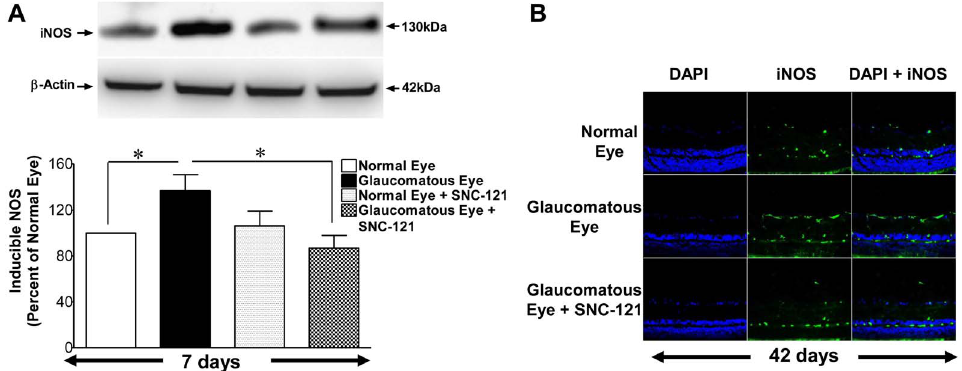
Figure 9. Changes in iNOS expression in glaucomatous retina at 7 and 42 days, post injury. (A) Brown Norway rats were treated with SNC-121 (1 mg/kg, i.p.) 30 minutes after glaucomatous injury and continued for 7 days, once daily. Retina extracts were collected at the 7 th day, post injury, and analyzed using anti-iNOS antibodies and appropriate secondary antibodies (HRP-conjugated; dilution 1:3000). The signal was captured using enhanced chemiluminescent reagent and the Biorad Versadoc imaging system. Data are expressed as mean 6 SEM. * P , 0.05; n=4. (B) The eyes of Brown Norway rats were removed 42-days post glaucomatous injury. Cryosections of retina were immunostained by anti-iNOS antibodies as indicated horizontally. Ocular treatments are indicated vertically. Data shown in this Figure are a representation of at least four independent experiments.